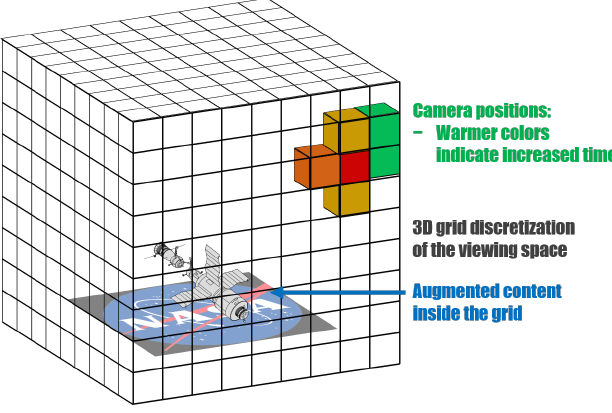
Figure 5. 3D analytics concept showing the 3D grid over the augmented objects, as well as the hotspots of the user position as colored